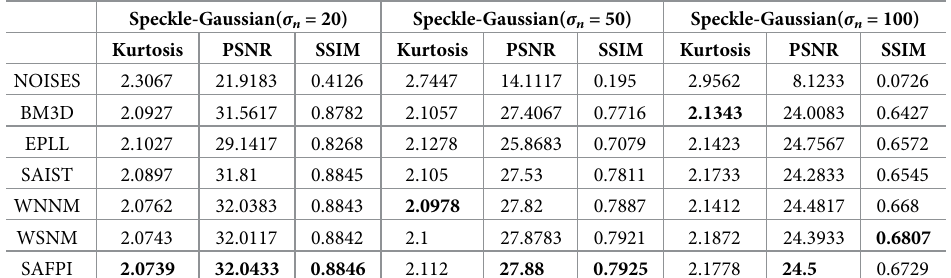
Table 8. Average denoising results of different algorithms for Speckle-Gaussian noise. Speckle-Gaussian( σ n = 20) Speckle-Gaussian( σ n = 50)